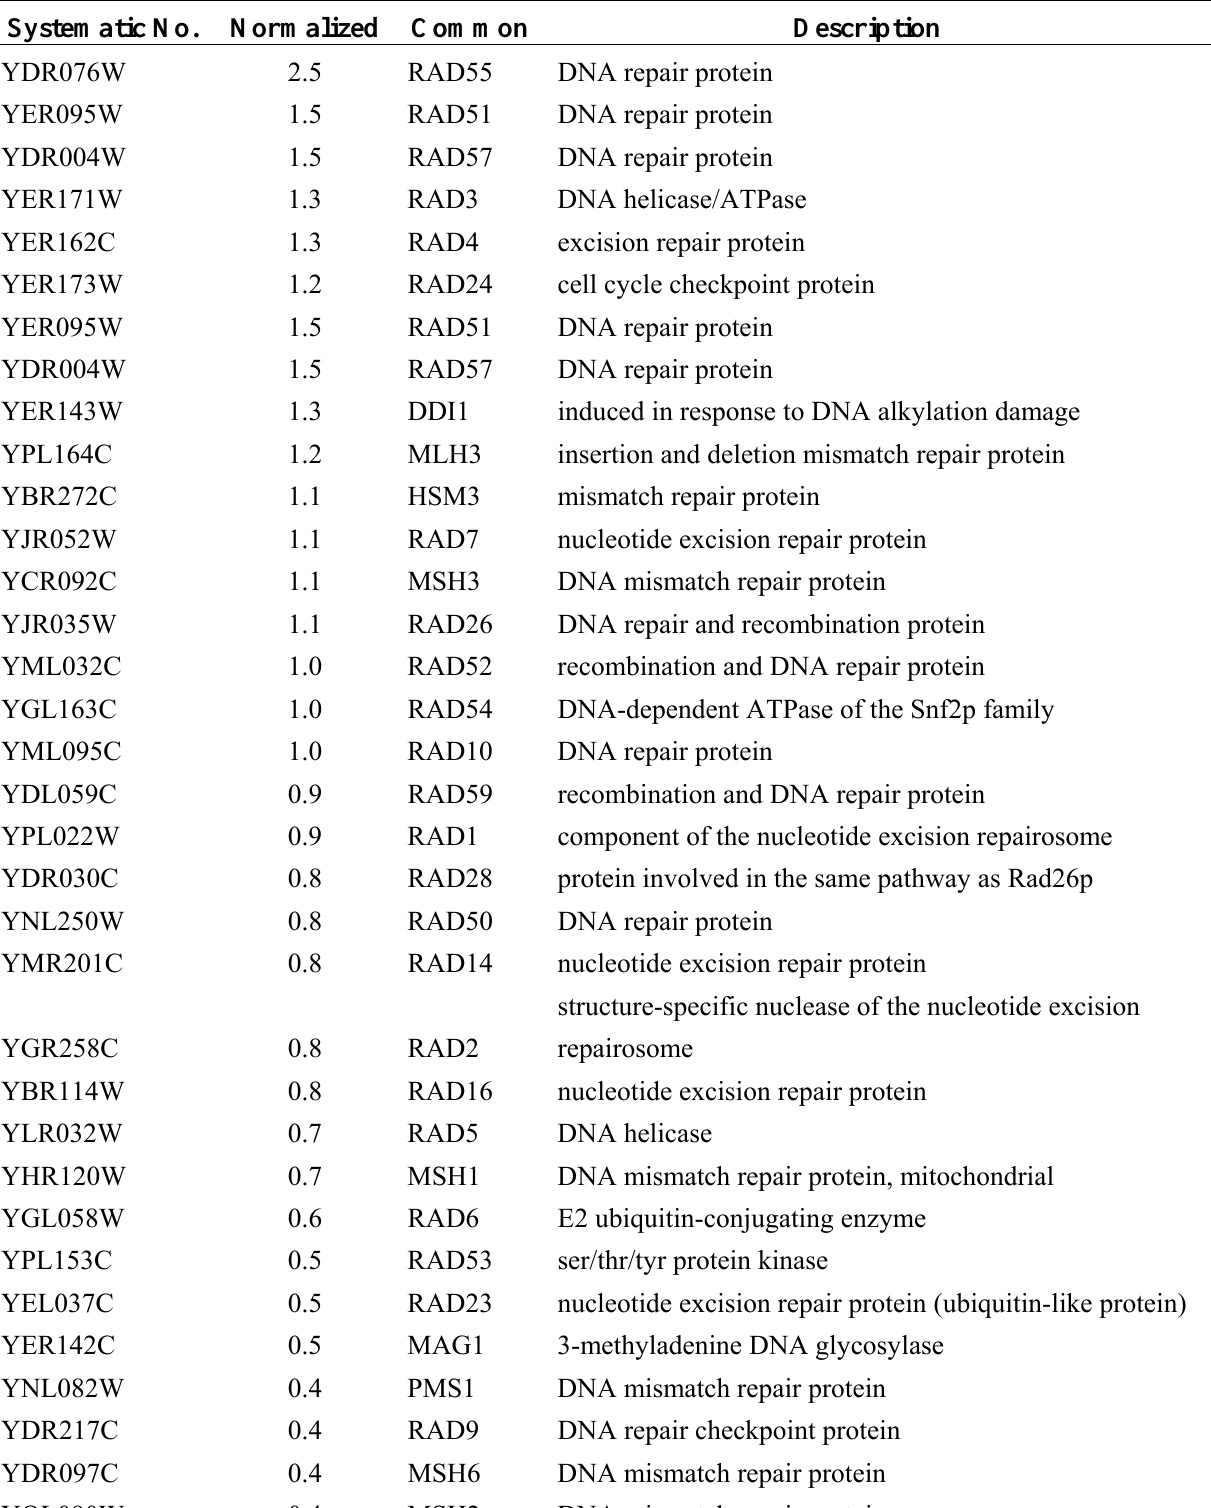
Table 3. Genes involved in the repair of double-stranded breaks in DNA. Systematic No. Normalized Common